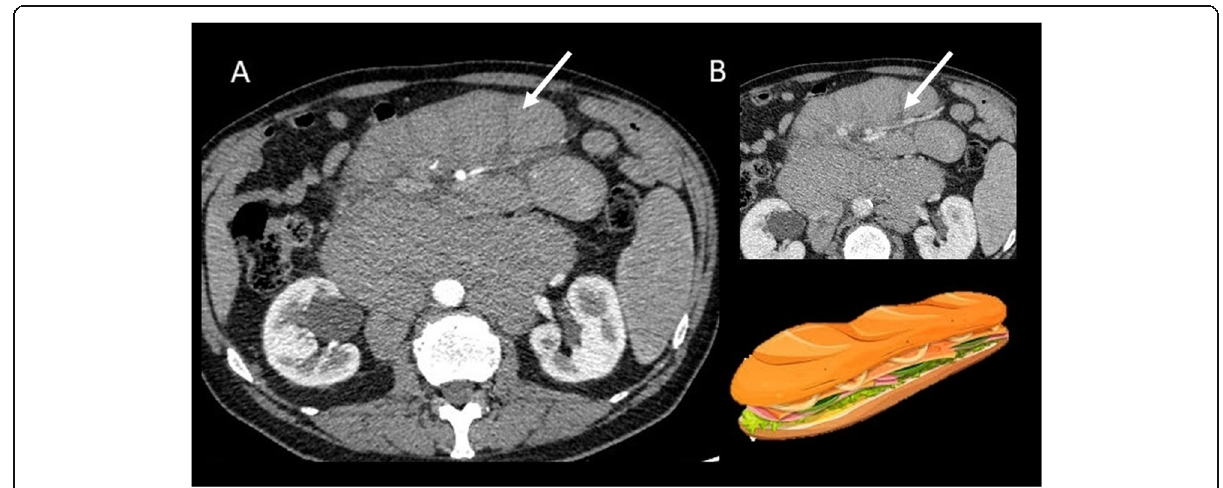
Fig. 10 Patient affected by non-Hodgkin lymphoma with both retroperitoneal and mesenteric locations. CT images show a large lesion with well-defined margins and homogeneous enhancement both on arterial ( a ) and portal ( b ) phases. Confluent lymphadenopathy on both sides of the mesenteric vessels gives rise to an appearance described as the sandwich sign that is specific for mesenteric